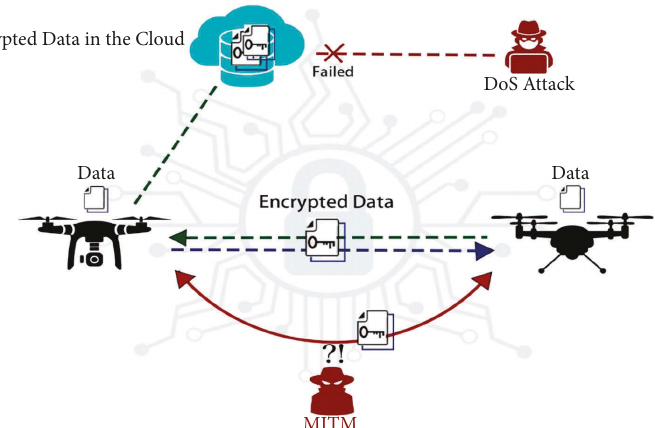
Figure 2: Data encryption and security attacks in aerial networks.